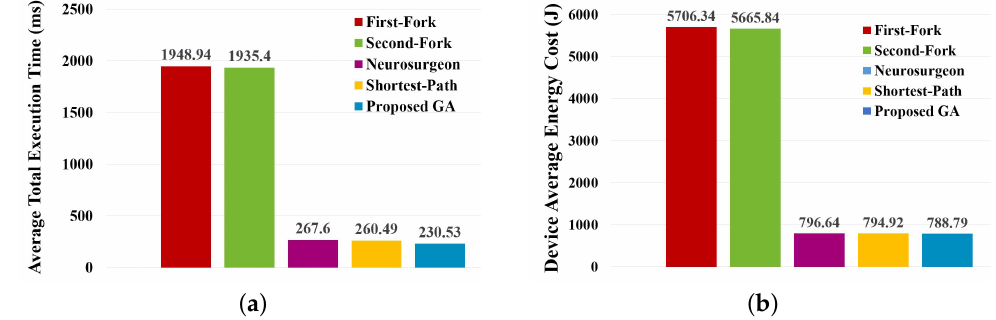
Figure 7. Performance comparison on partitioning B-ResNet by considering partitioning and deploy- ing separately. ( a ) Comparison on average total execution time. ( b ) Comparison on device-average energy cost. Table 8. Comparison of B-ResNet total execution (ms) resulted by different approaches.